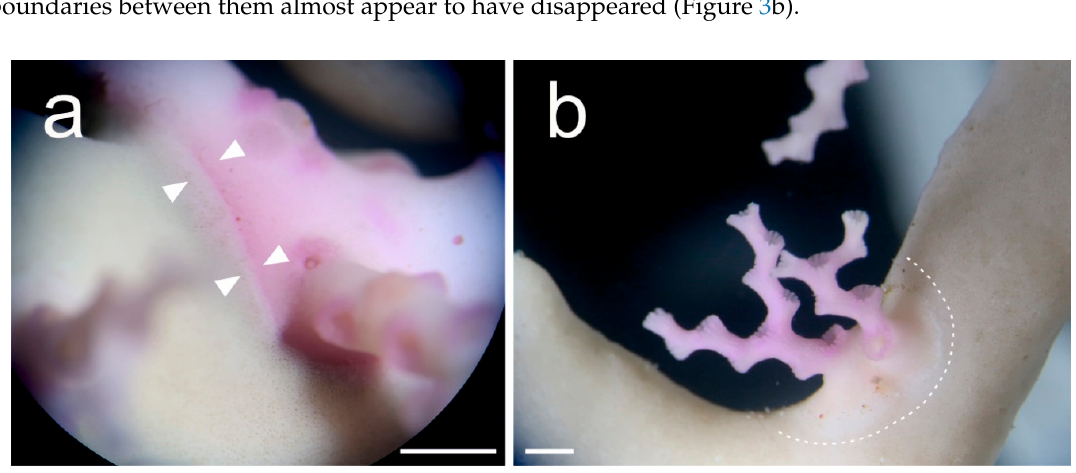
Figure 3. ( a ) Apparently healthy tissue of both partners when intimately close, and ( b ) the undefined borders/edges between the two hydrocorals’ tissues. (Scale bars ⁓ 2 mm).